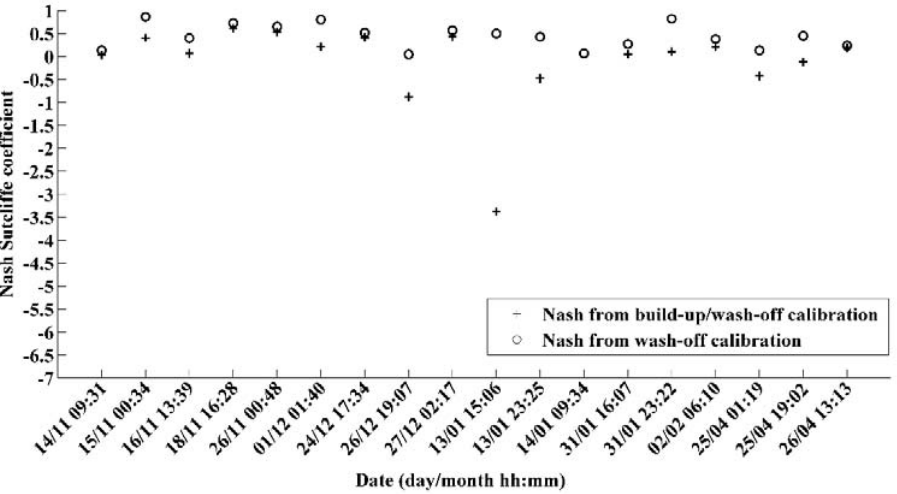
Figure 11. Comparison of the Nash coefficients calculated when calibrating the build-up and wash-off on periods of three successive events and the Nash coefficients calculated when calibrating the wash.